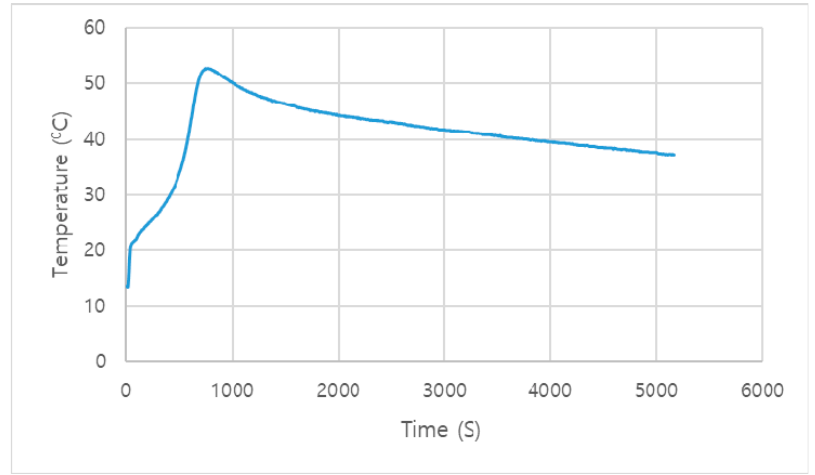
Figure 4. Activity test of ESP.